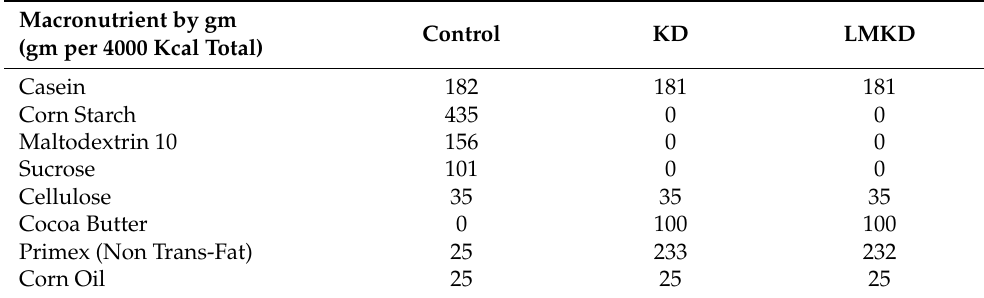
Table 1. Acronutrient composition of the experimental diets (control, ketogenic diet, KD; and low methyl ketogenic diet,